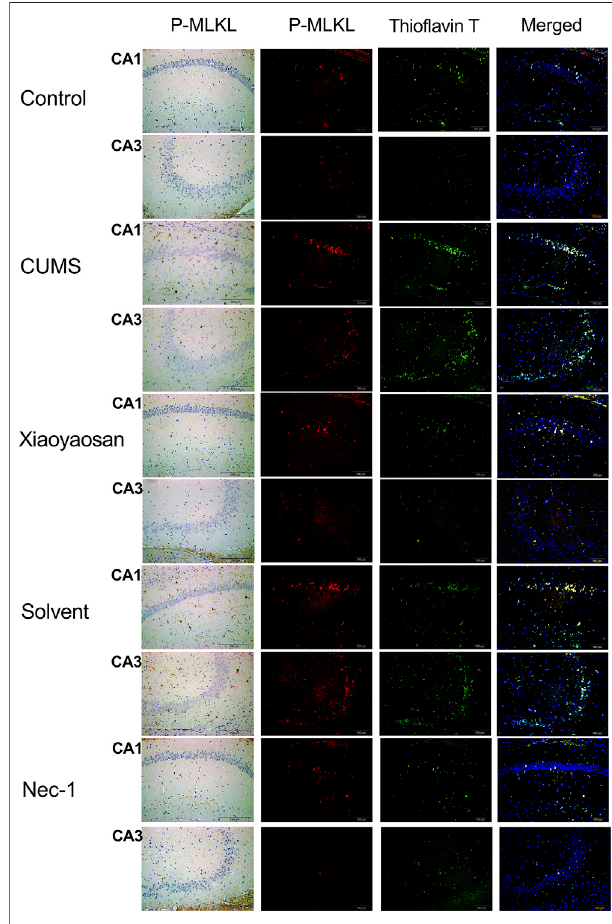
FIGURE 7 | Representative micrographs of IHC and IF staining for p -MLKL (scale bar (cid:1) 200 μ m, × 400 magni fi cation) in the CA1 and CA3